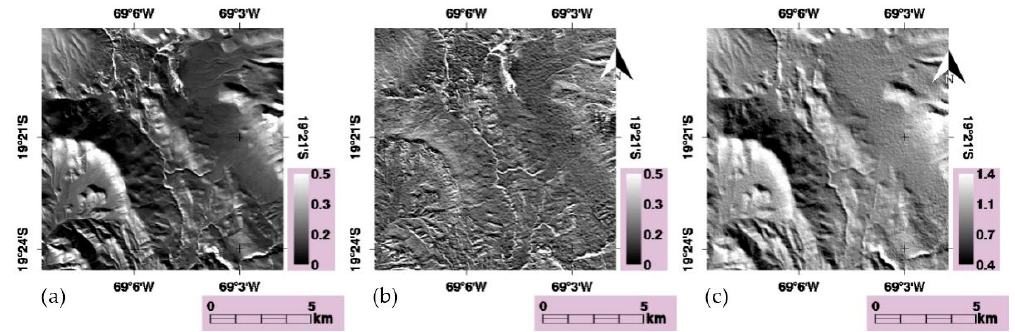
Figure 11. Normalized spectral distance (nsd) images before ( a ) and after ( b ) topographic correction; DEM derived angle between the incoming solar radiation and the normal to the surface related to the winter image ( c ).